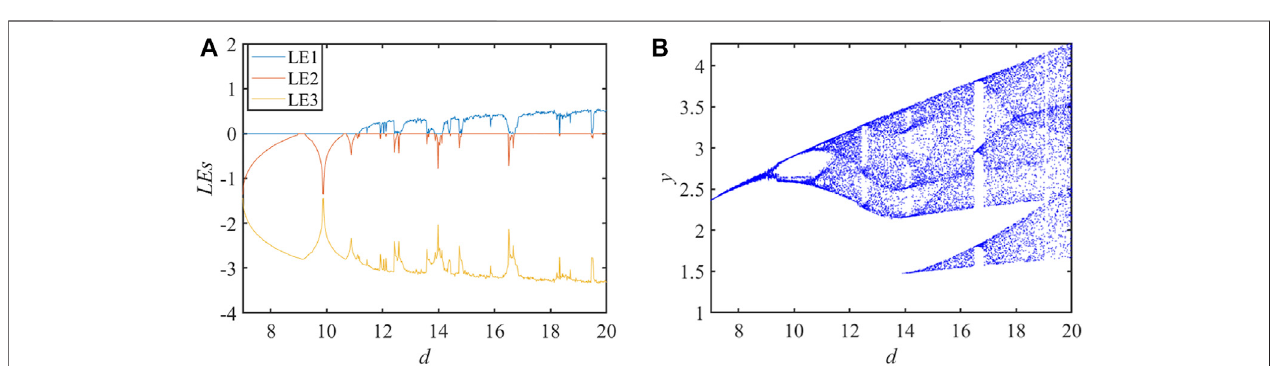
FIGURE 6 | Dynamical analysis with parameter d , (A) LEs, (B) BD.